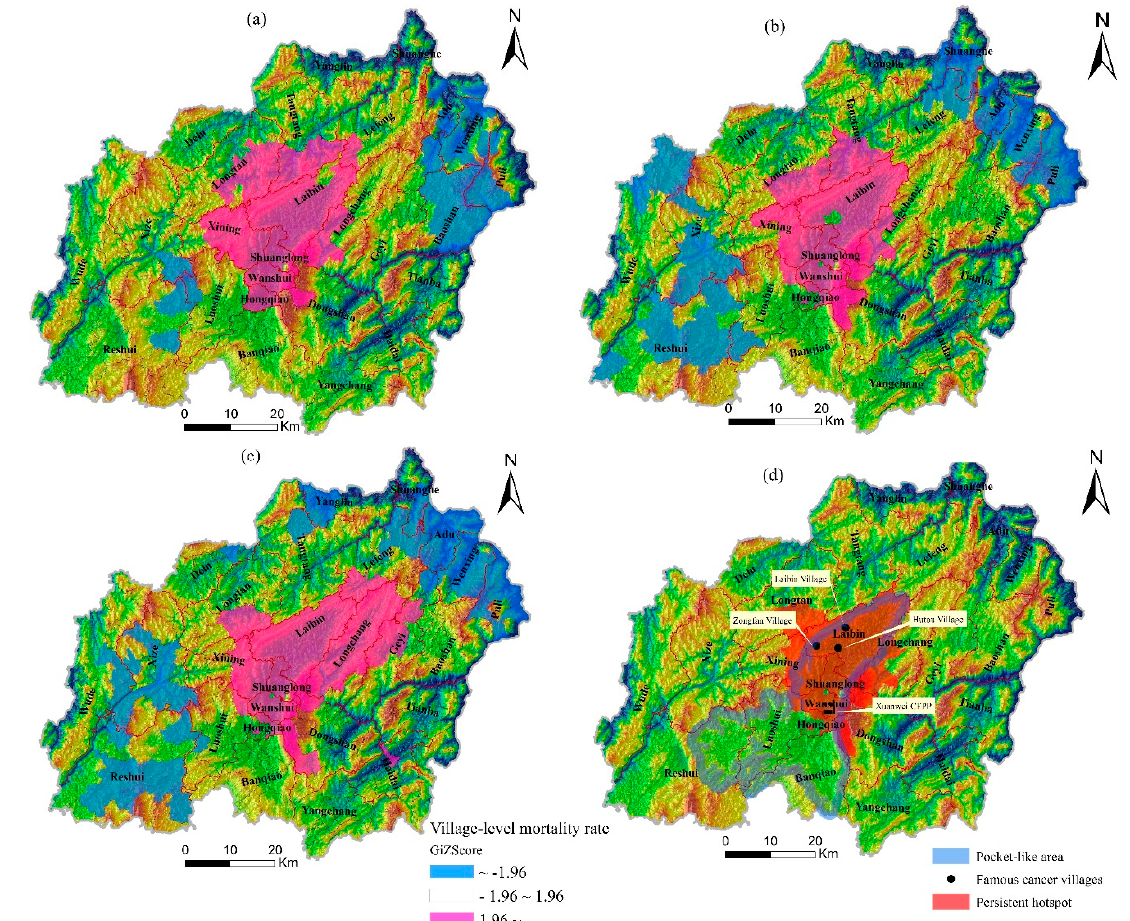
Figure 5. Hotspot regions of the village-level mortality rate of lung cancer 1990–1992 ( a ); 2004–2005 ( b ); 2011–2013 ( c ); and 1990–2013 ( d ). CFPP is the abbreviation for coal-fired power plant.